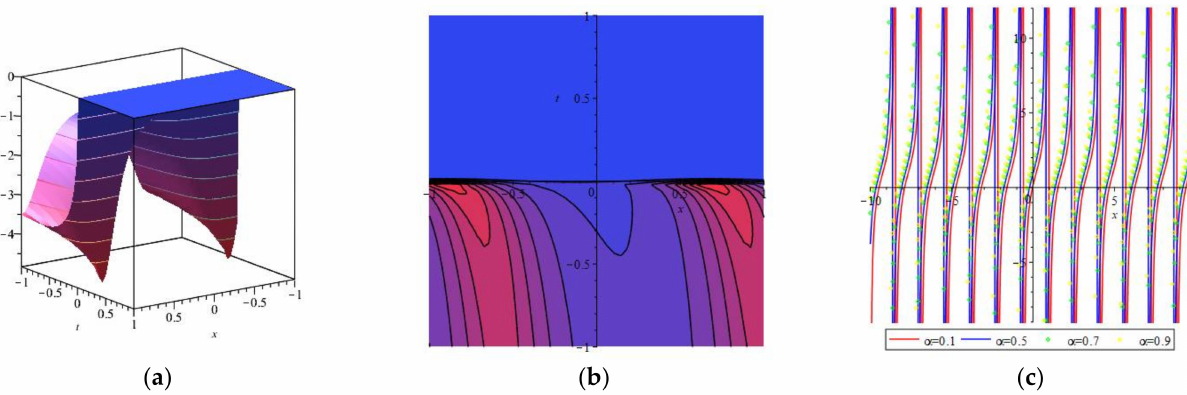
Figure 10. The graphical representation of the solution λ 34 ( χ ) : ( a ) 3D shape, ( b ) contour plot, and ( c ) 2D